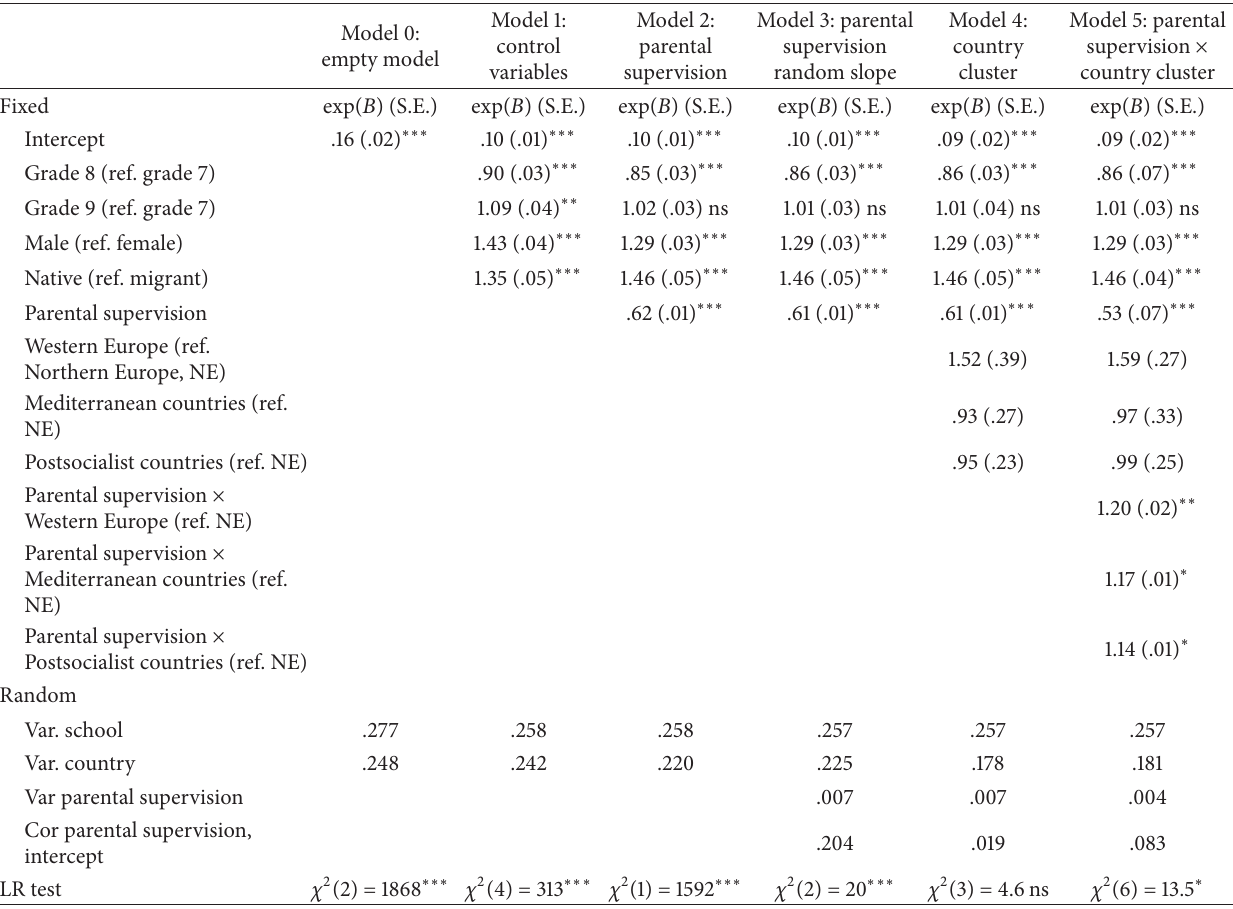
Table 5: The results of multilevel analysis concerning parental supervision ( 𝑛 individuals: 52564; 𝑛 schools: 1344; 𝑛 countries: